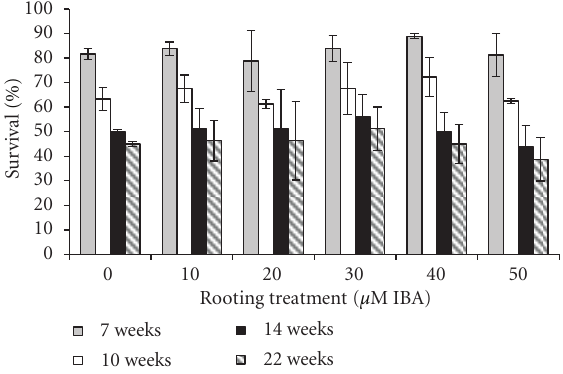
Figure 3: E ff ect of indole butyric acid (IBA) concentration used in in vitro rooting of Handroanthus impetiginosus on plant survival percentage during acclimatization